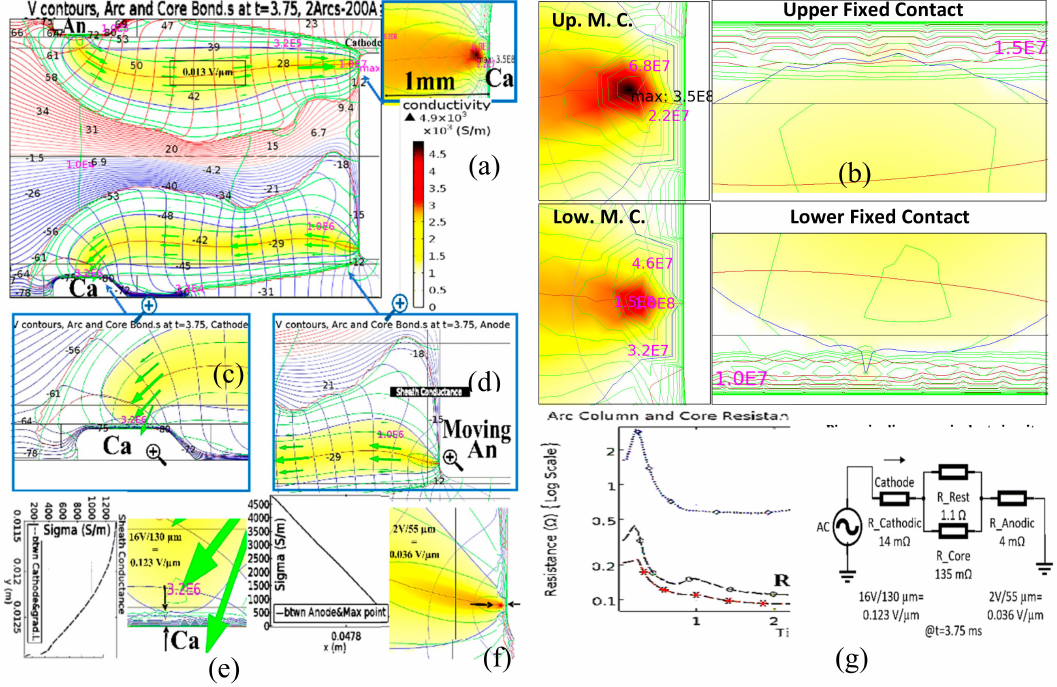
Figure 14. ( a , b ) Arc boundaries, V contours, and J norm in Log. scale and the zoomed view of the near electrode areas at ( c ) Fixed cathode, ( d ) Moving anode, ( e ) Diagram of σ sheath ( x , t ) cathode to the core gradient line, ( f ) Diagram of the σ sheath ( y , t ) and ( g ) Simulated arc and core resistance and piecewise linear equivalent circuit of R arc | t = 3.75 ms for 200 A peak ; (An, Ca, and MC in figures refer to the anode, cathode, and the moving